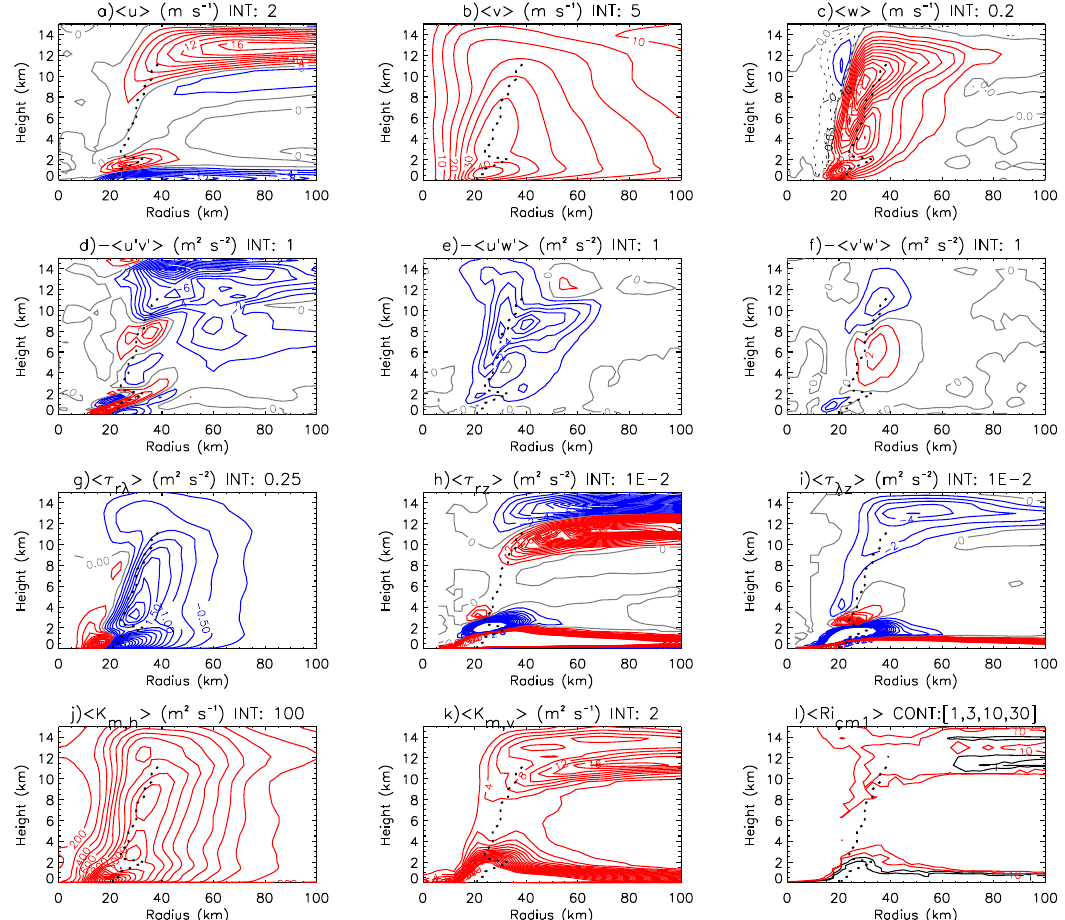
Fig. 15. Radius-height contour plots of resolved and subgrid-scale eddy momentum fluxes and related quantities from the 3D3k simulation using data at a 2-minute interval and averaged over the second intensification interval (144 - 148 h). Contour intervals are the same as in Fig. 14. Except where otherwise noted, there are 20 positive red contours and 20 negative blue contours. Panel (a): h u i with contour interval 2 m s − 1 ; panel (b): h v i with contour interval 5 m s − 1 ; panel (c): h w i with contour interval 0.2 m s − 1 ; panel (d): resolved horizontal momentum flux h− u ′ v ′ i with contour interval 1 m 2 s − 2 ; panel (e): resolved vertical eddy flux of radial momentum h− u ′ w ′ i with contour interval 1 m 2 s − 2 ; panel (f): resolved vertical eddy flux of tangential momentum h− v ′ w ′ i with contour interval 1 m 2 s − 2 ; panel (g): subgrid momentum flux corresponding to panel (d): h τ rλ i with contour interval 0.25 m 2 s − 2 ; panel (h): subgrid momentum flux corresponding to panel (e) h τ rz i with contour interval 1 × 10 − 2 m 2 s − 2 ; panel (i): subgrid momentum flux corresponding to panel (f) h τ λz i with contour interval 1 × 10 − 2 m 2 s − 2 ; panel (j): horizontal diffusivity h K m,h i with contour interval 100 m 2 s − 1 ; panel (k): vertical diffusivity h K m,v i with contour interval 2 m 2 s − 1 ; panel (l): time and axisymmetric average of the gradient Richardson number used in the CM1 model h Ri cm 1 i with black contours 1 and 3 and red contours 10 and 30. The radius of maximum h v i at each height is shown with the black dashed curve (up to 11 km).